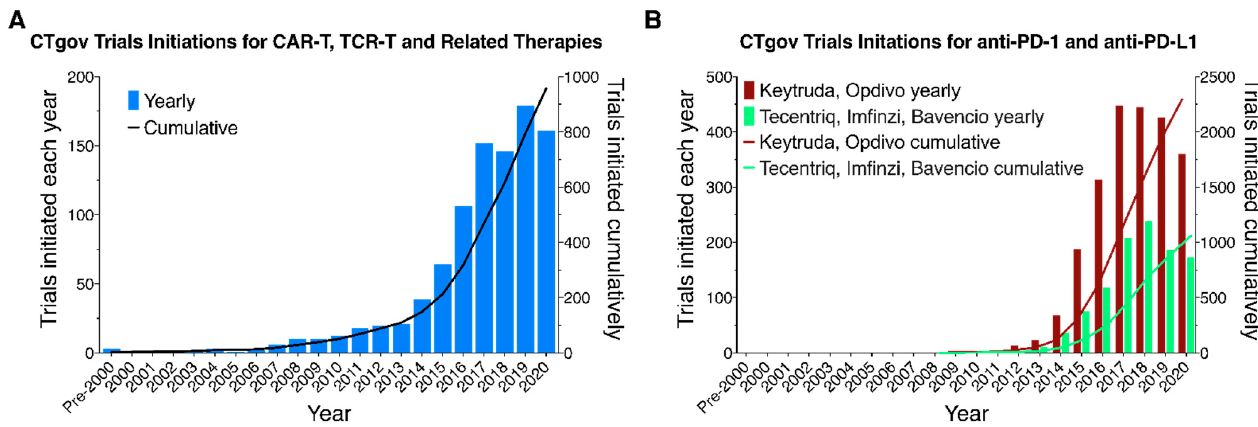
Figure 2. Yearly and cumulative numbers of CAR-T/TCR-T clinical trials registered on clinicaltrials.gov and initiated on or before 31 December 2020, under FDA guidelines. ( A ) CAR-T/TCR-T and related cellular immunotherapies. ( B ) PD-1 (Keytruda, Opdivo) and PD-L1 (Tecentriq, Imfinzi, Bavencio) antibody therapies.